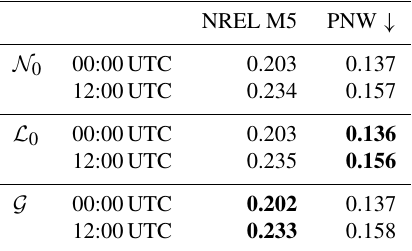
Table 1. Average CRPS (in ms − 1 ) for the 00:00UTC and 12:00UTC calibrated probabilistic forecasts obtained using the truncated normal ( N 0 ), truncated logistic ( L 0 ), and gamma ( G ) pre- dictive distribution models. The arrow represents the direction for good scores, and the best scores are shown in bold. NREL M5 PNW